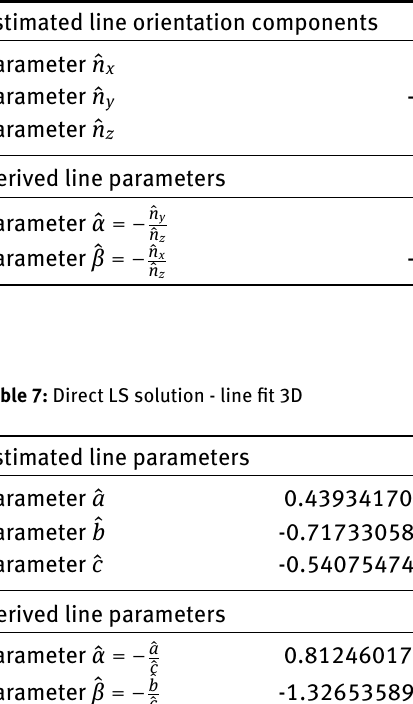
Table 6: LS solution for line fit in 3D from [31, p.64]